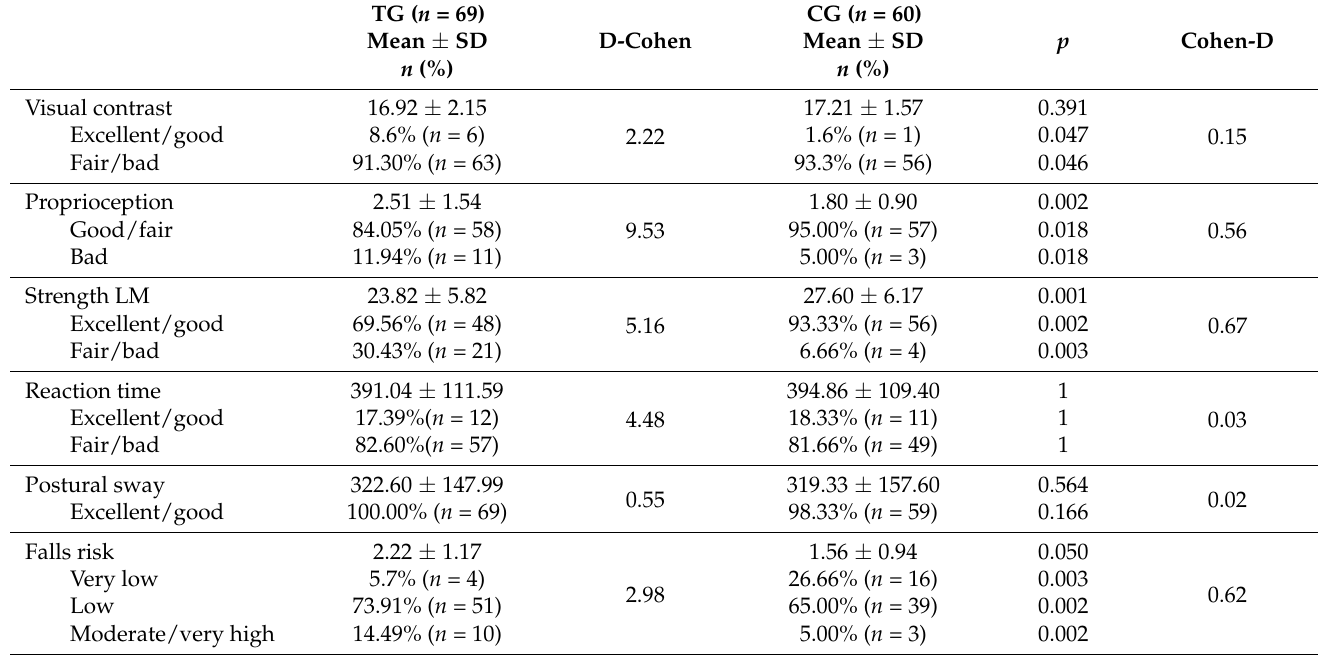
Table 3. Physiological profile assessment stratification of